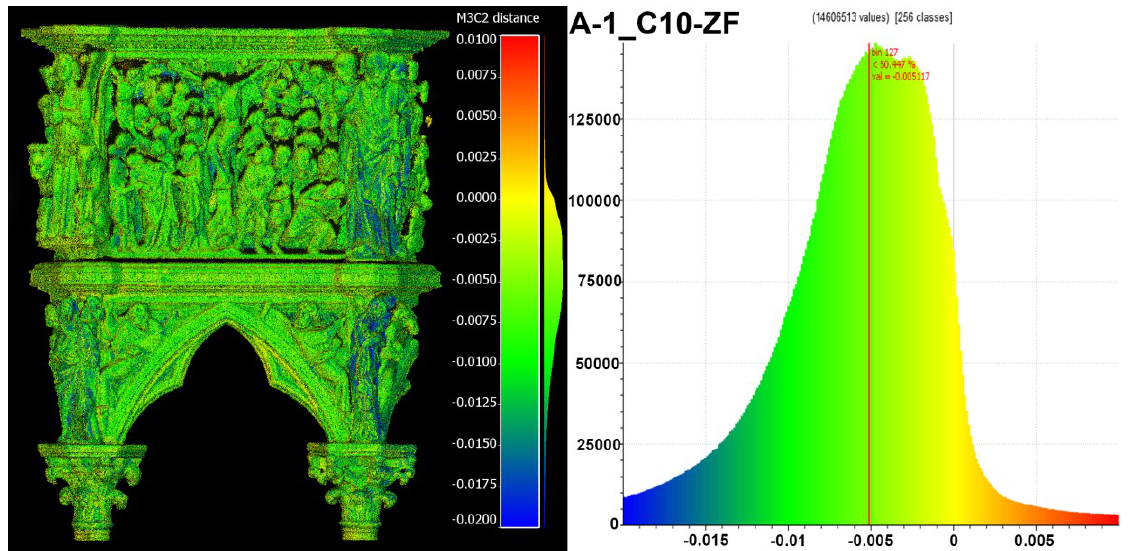
Figure 8 . C10 - ZF comparison and histogram.